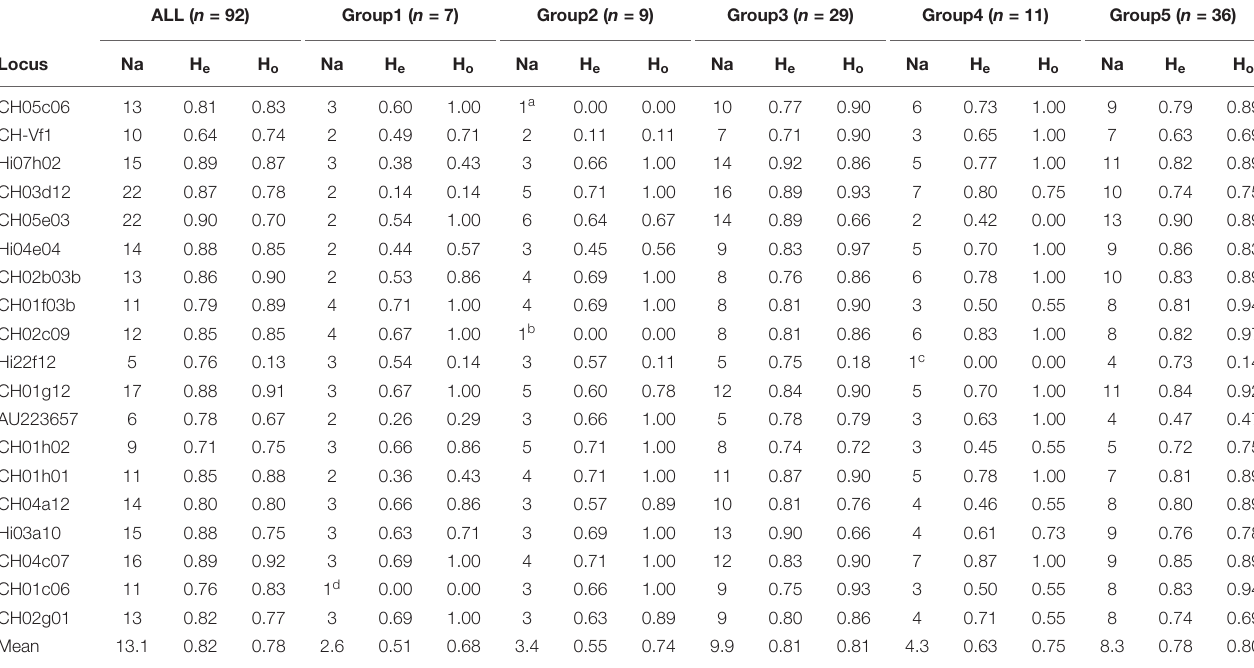
TABLE 5 | Number of alleles (Na), observed (H o ), and expected (H e ) eterozygosity for the five groups revealed by